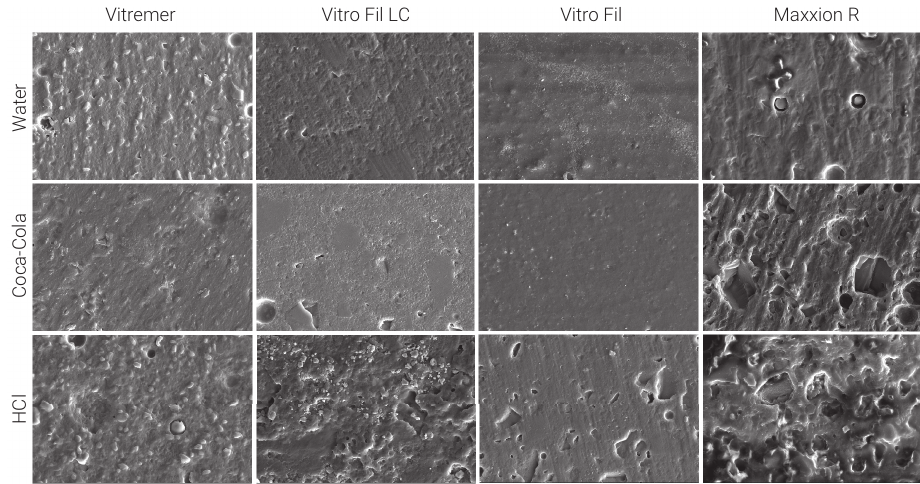
Figure 2. Representative scanning electron micrographs of GICs after tests. Original magnification 1000 kX. Greater degradation can be seen in images after immersion in HCl solution, with more rugged surfaces observed for all GICs. Similar degradation can be seen in images of self-cured GICs after immersion in